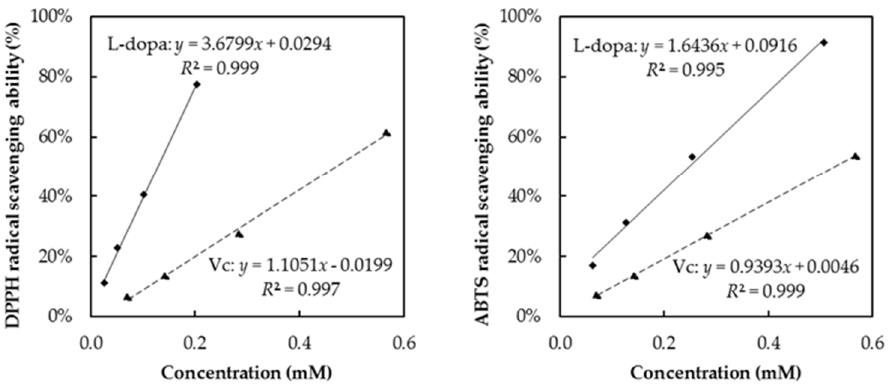
Figure 5. Antioxidant activity of standard compounds of L-dopa and vitamin C.